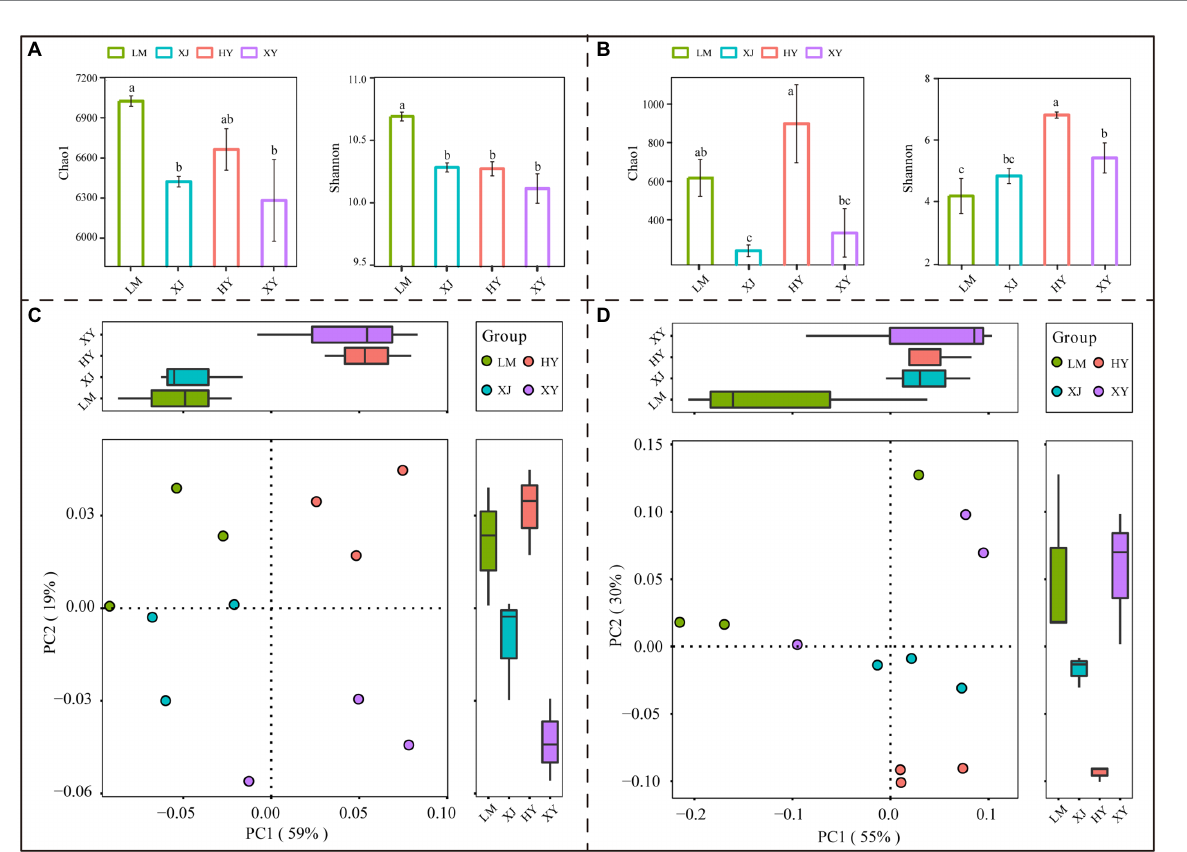
FIGURE 1 Chao1 index, Shannon index, and principal-coordinate analysis (PCoA) of bacteria and fungi from four Populus species. (A) The bacterial alpha diversity. (B) The fungal alpha diversity. (C) The bacterial principal component analysis. (D) The fungal principal component analysis. Different lower letters mean significant differences ( p < 0.05). The same lowercase letters mean that the difference is not significant in four Populus species ( p >